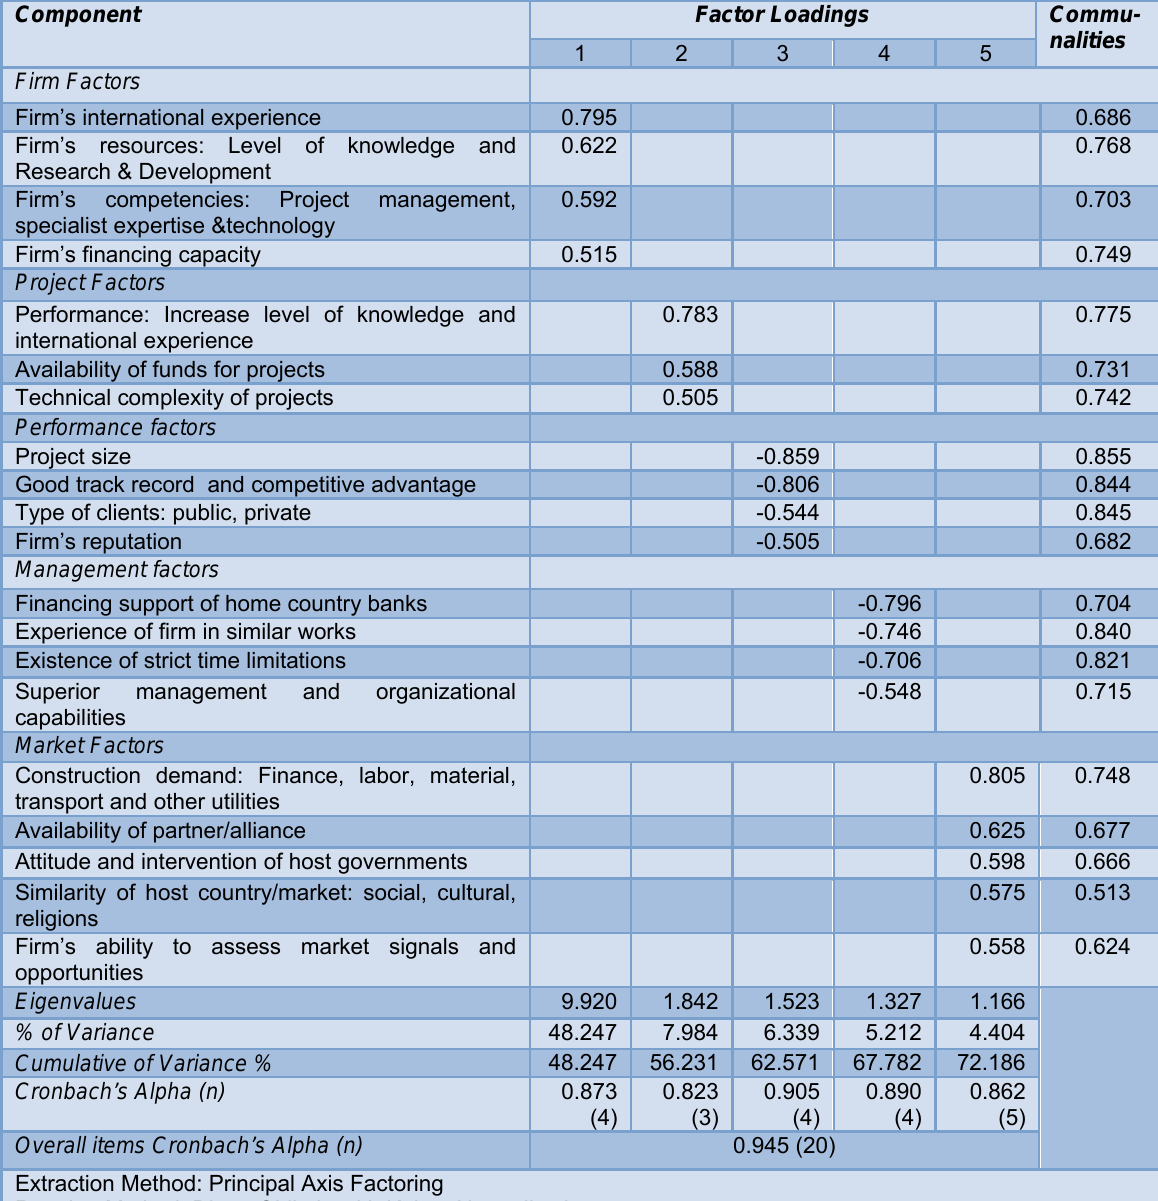
Table 5 Factor loadings using Principal Axis Factoring (PAF) for ET